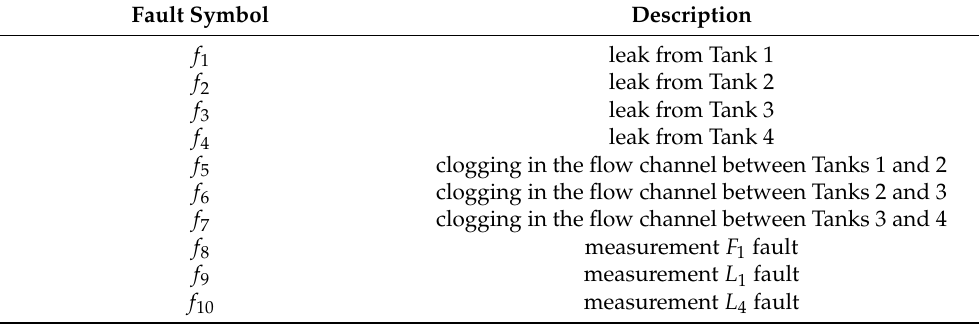
Table 4. A set of faults. Fault Symbol